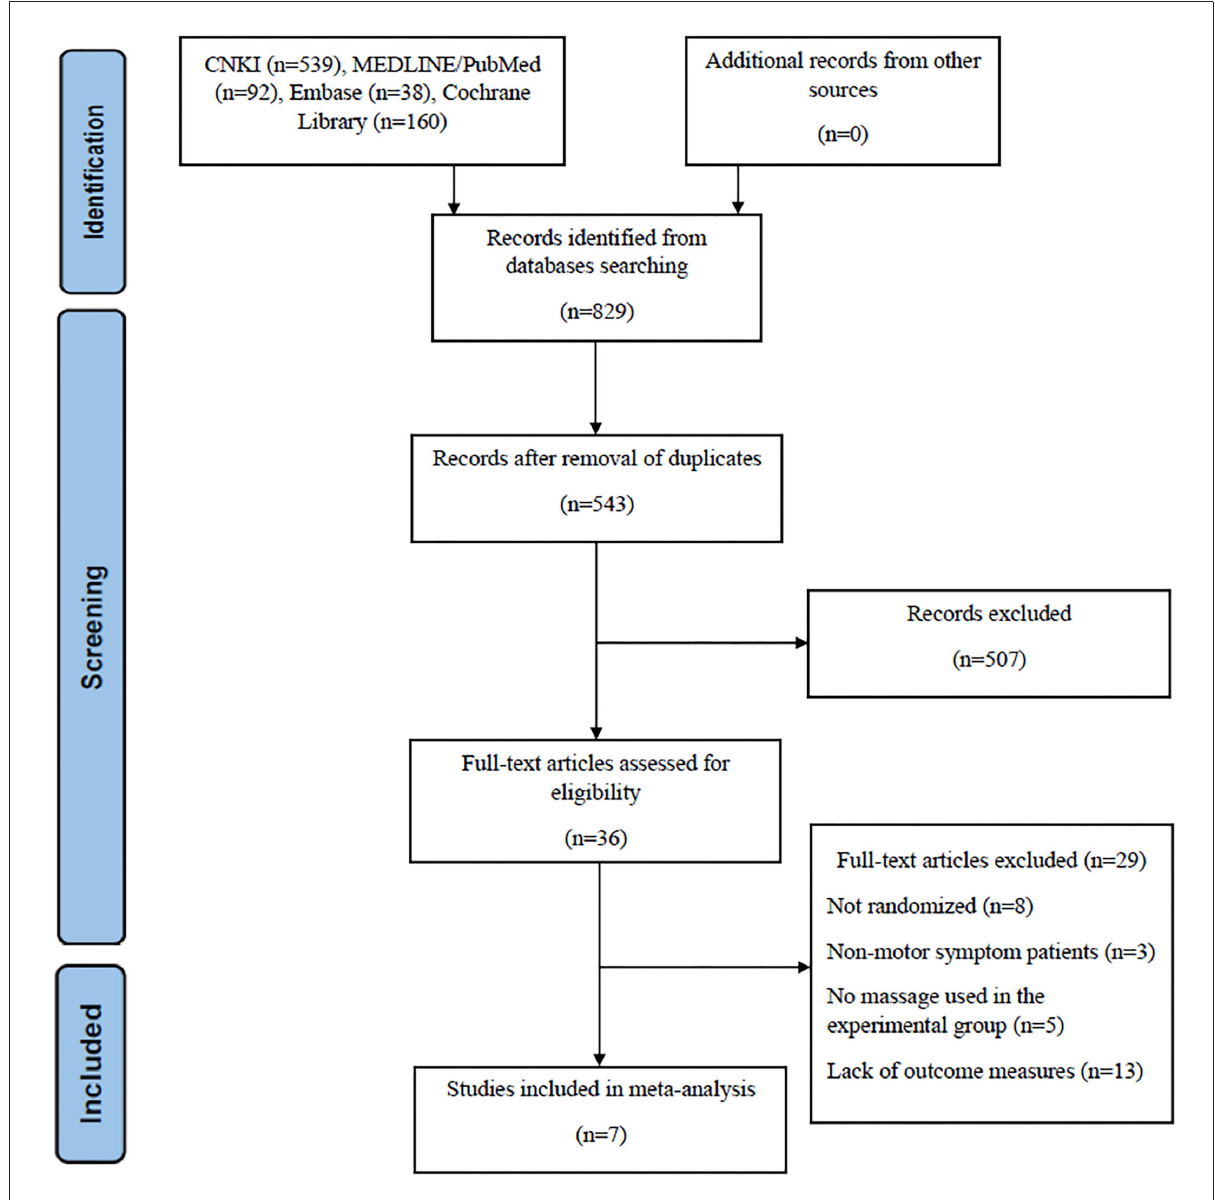
FIGURE1 The 2020 version of the PRISMA flowchart showing the selection of included